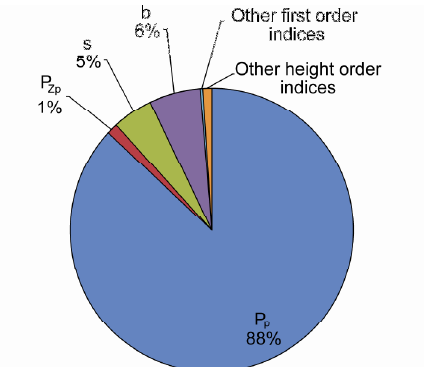
Fig. 13. Results for the first terrace